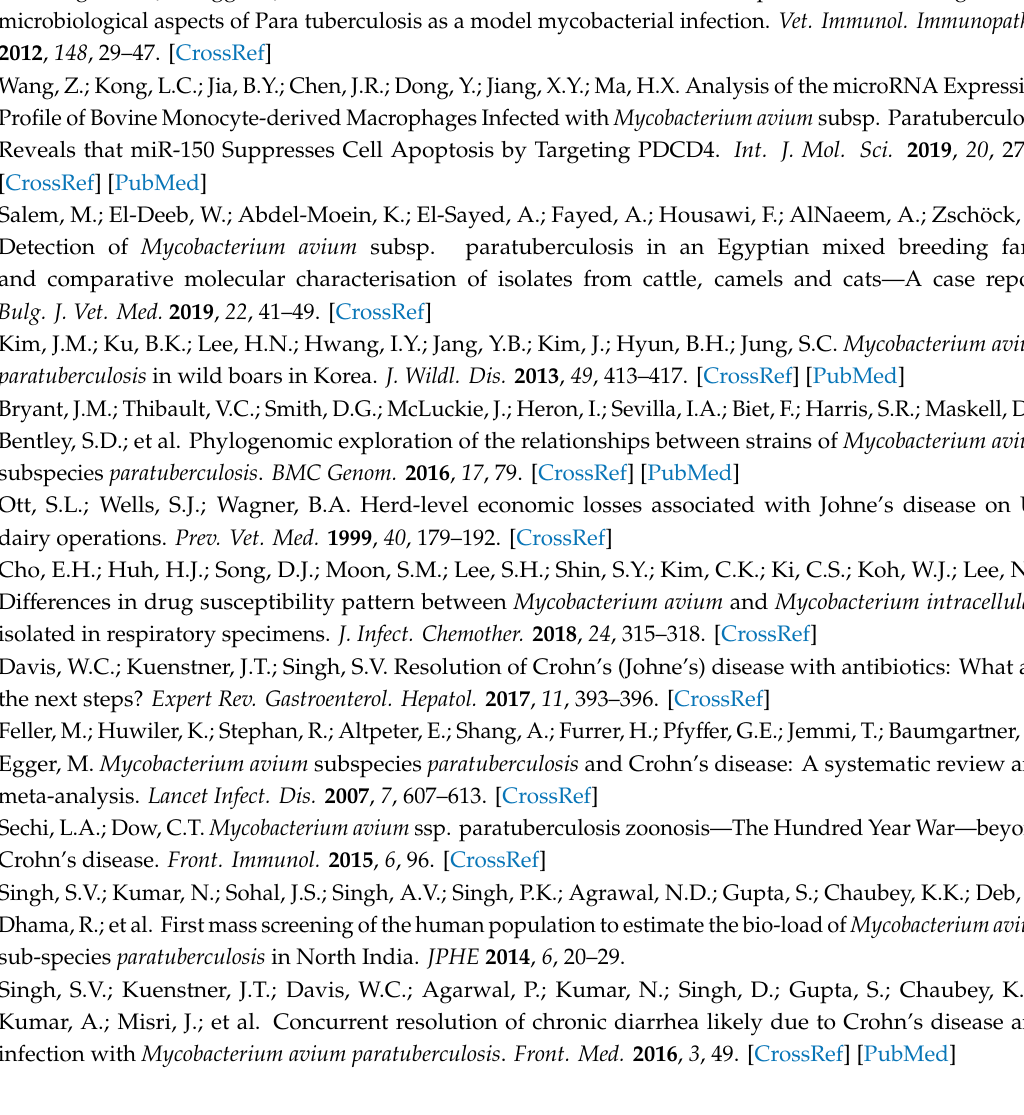
Table S1: MAP research total citations per country, Table S2: Growth of MAP research in relation to 52 scientific subject areas., Table S3: MAP research growth by country from 2017–2019, Table S4: Growth of MAP research based on institution participations in the last 3